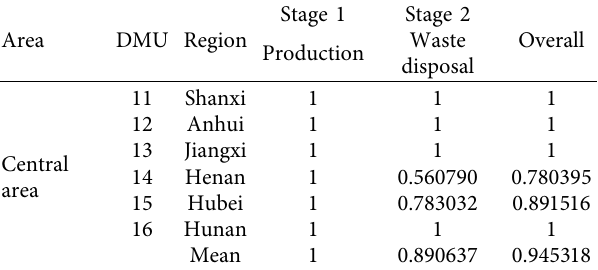
Table 7: Area-wise efficiency evaluation results in the Central